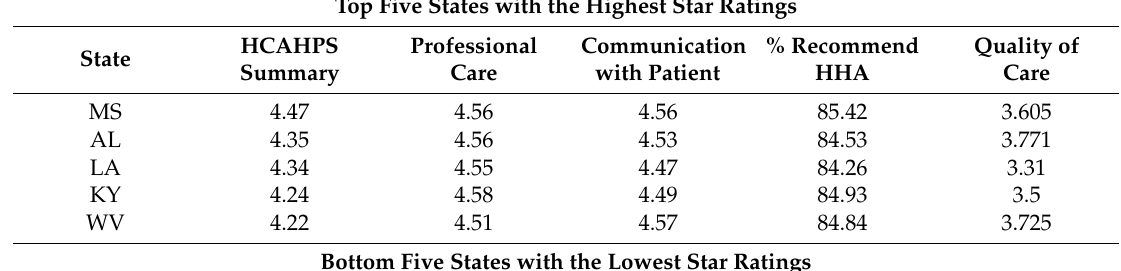
Table 4. US states with the top and bottom five mean star ratings. Top Five States with the Highest Star